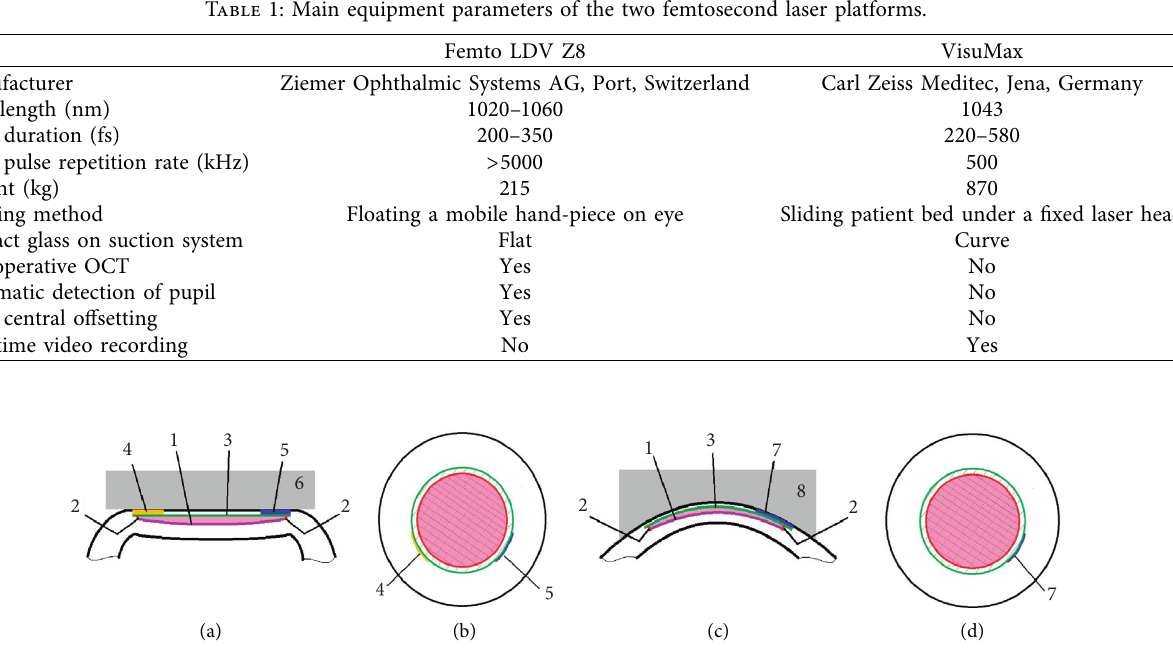
Figure 1: Incision geometry of the SMILE procedures by the two femtosecond laser platforms. (a), (b) The geometry of incisions which were created by the Femto LDV Z8; (c), (d) The geometry of incisions which were created by the VisuMax. 1, incision for cutting the posterior surface of the lenticule; 2, lenticule sidecut; 3, incision for cutting the anterior surface of the lenticule; 4, one of two incisions for opening cap by Femto LDV Z8 (usually used for identifying one side of the lenticule surface); 5, the other of two incisions for opening cap by Femto LDV Z8 (usually used for identifying the other side of the lenticule surface); 6, the flat contact glass of suction system in Femto LDV Z8; 7, the only incision for opening cap by VisuMax (usually used for identifying the two sides of lenticule surfaces ); 8, the curved contact glass of suction system in VisuMax. Pink areas indicate the lenticules after SMILE surgeries. Table 2: Satisfaction scores on the surgical processes using two femtosecond laser platforms. Platform Eye no.